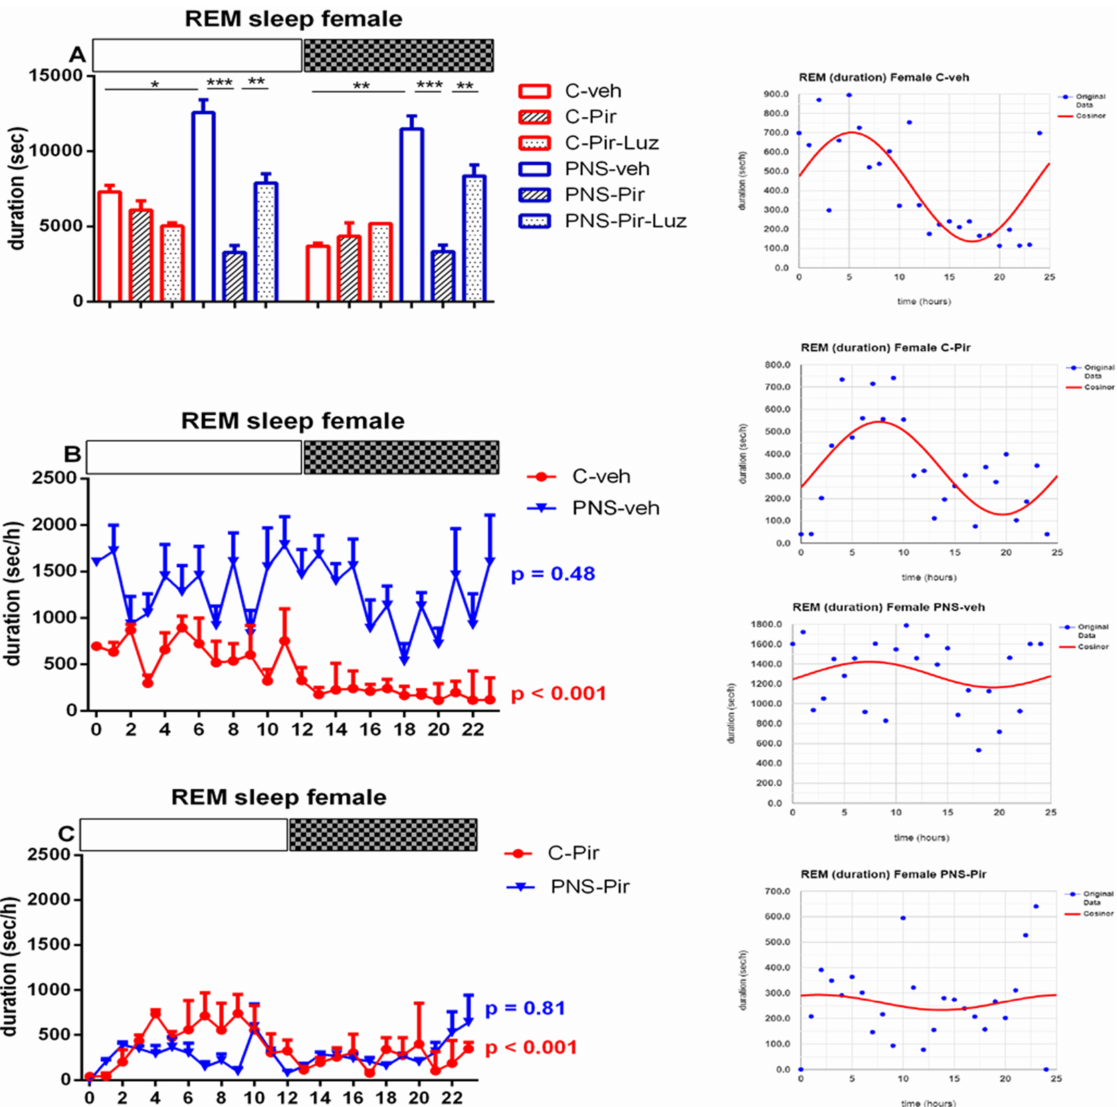
Figure 10. Diurnal rhythm of REM duration (sec/h) in female rats during the Light and the Dark phase, indicated by open and black rectangles above the figure, over a 24-h recording for C-veh, C-Pir, C-Pir-Luz, PNS-veh, PNS-Pir, and PNS-Pir-Luz group ( A ). Circadian distribution of REM sleep events (duration, sec/h) for C-veh and PNS-veh groups ( B ) and C-Pir and PNS-Pir groups ( C ) over a 24-h recording. Original and cosinor data are shown in the inset on the right. * p < 0.05, ** p < 0.01, *** p < 0.001 vs. C-veh, PNS-veh or PNS-Pir group,